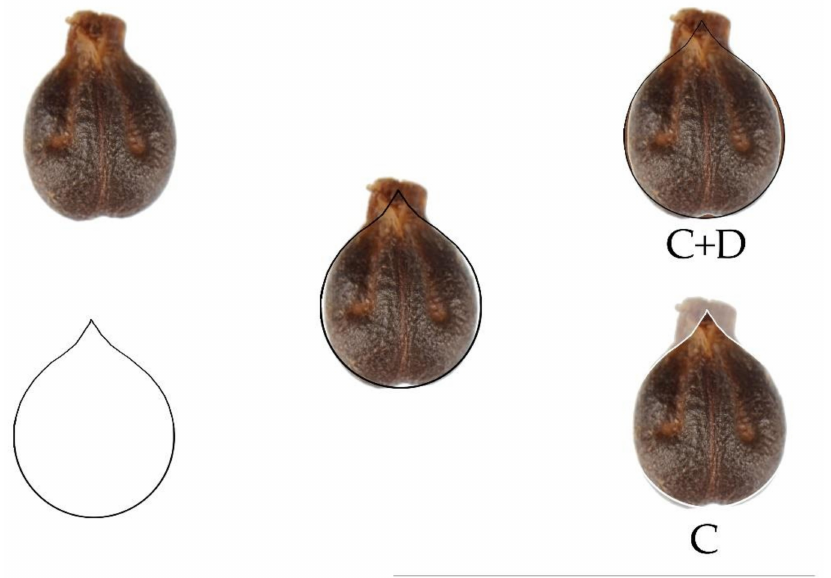
Figure 4. Method for obtaining the J index (percentage of similarity between two images; the geometric figure and the seed image). Left: the seed ( V. amurensis ) and the geometric model (M3). The composed image, in the center contains both the seed and the model. Right: total surface occupied by both figures (top) and shared surface (bottom). The surface comprised in the white perimeter is the common region, C; while total area (C + D) is obtained from the image in the right top figure. The J index is the ratio between the shared and the total area x 100. The bar is equal to 1